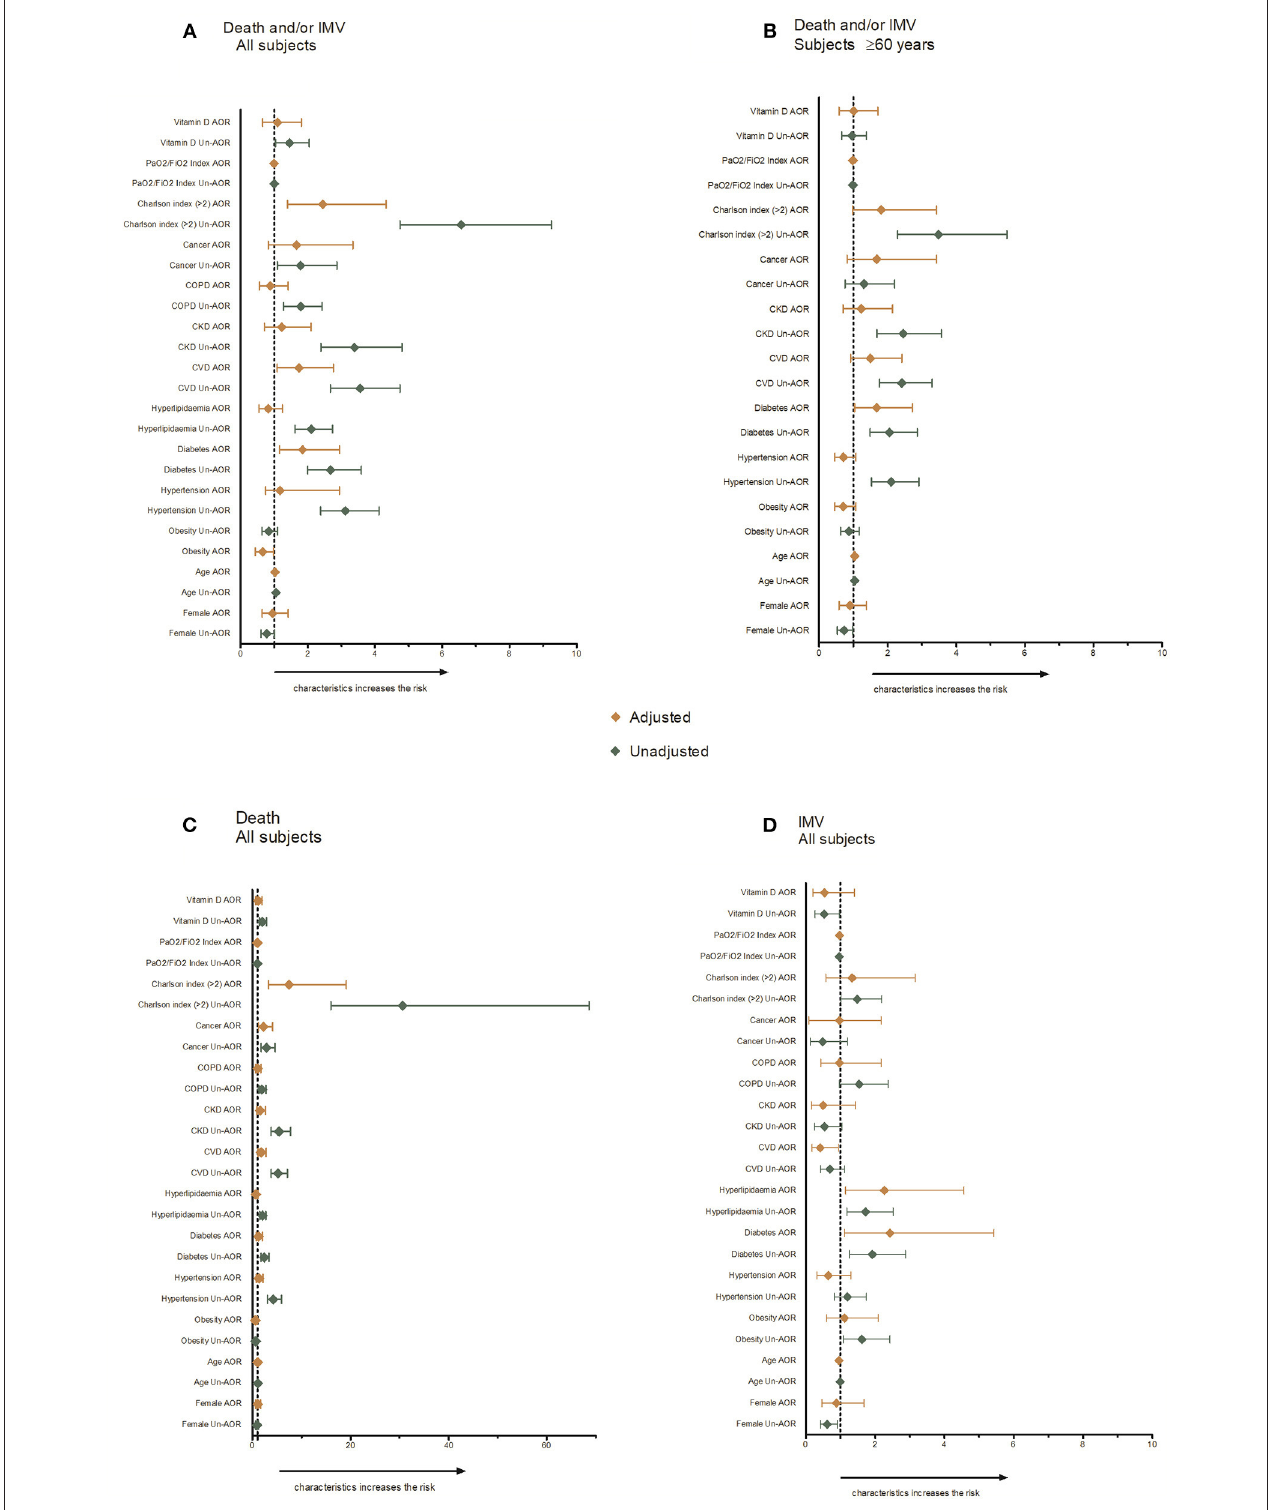
FIGURE 1 | Risk factors for severity